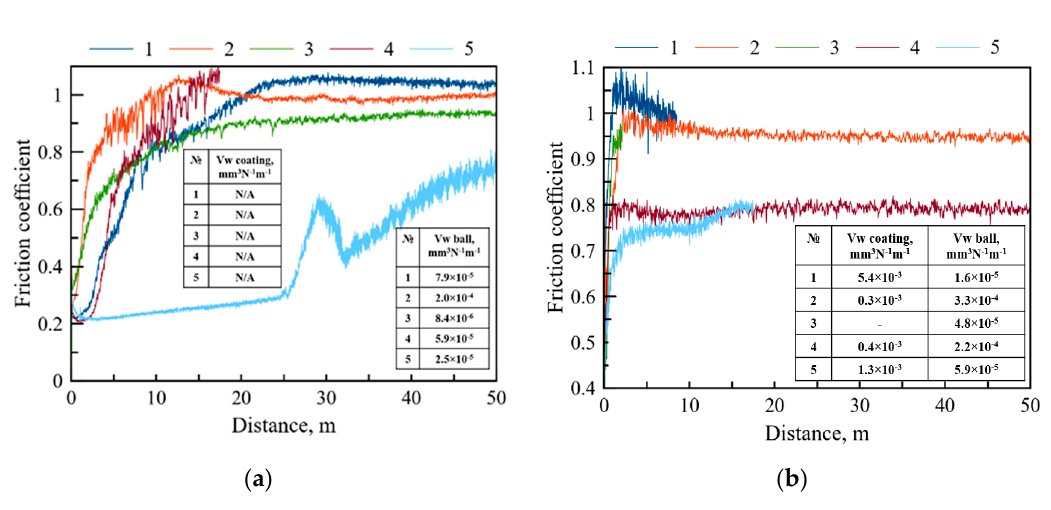
Figure 4. Friction coefficient vs. distance dependence during testing of coatings against 100Cr6 ( a ) and Al 2 O 3 ( b ) counterparts. Inserts show the values of wear rate for coatings and